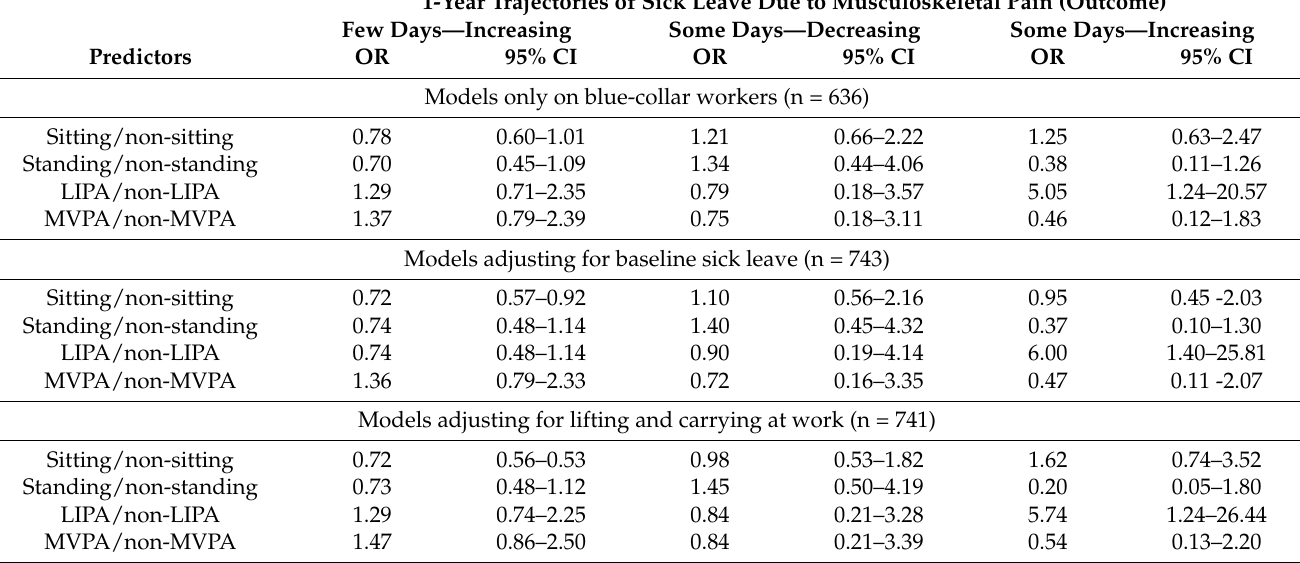
Table 3. Sensitivity analyses. Adjusted association between work-time compositions of physical behaviors and sick leave due to musculoskeletal pain. No sick leave was used as reference. Physical behavior data are expressed in isometric log-ratios (ILRs).